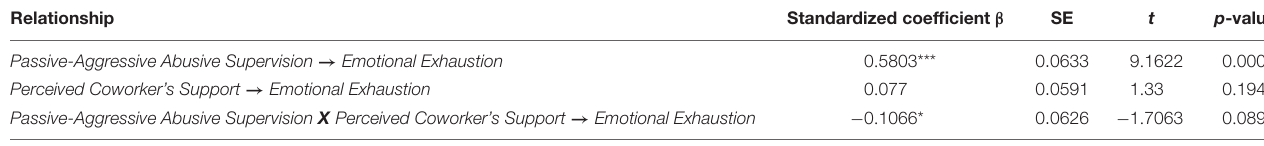
TABLE 5 | Moderation results with passive-aggressive abusive supervision.